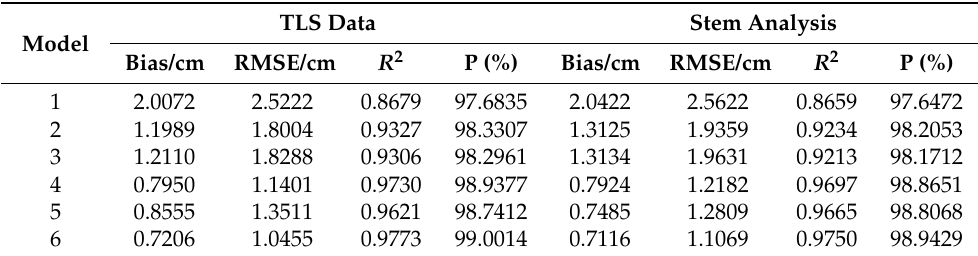
Table 5. Test statistics of the taper equation.